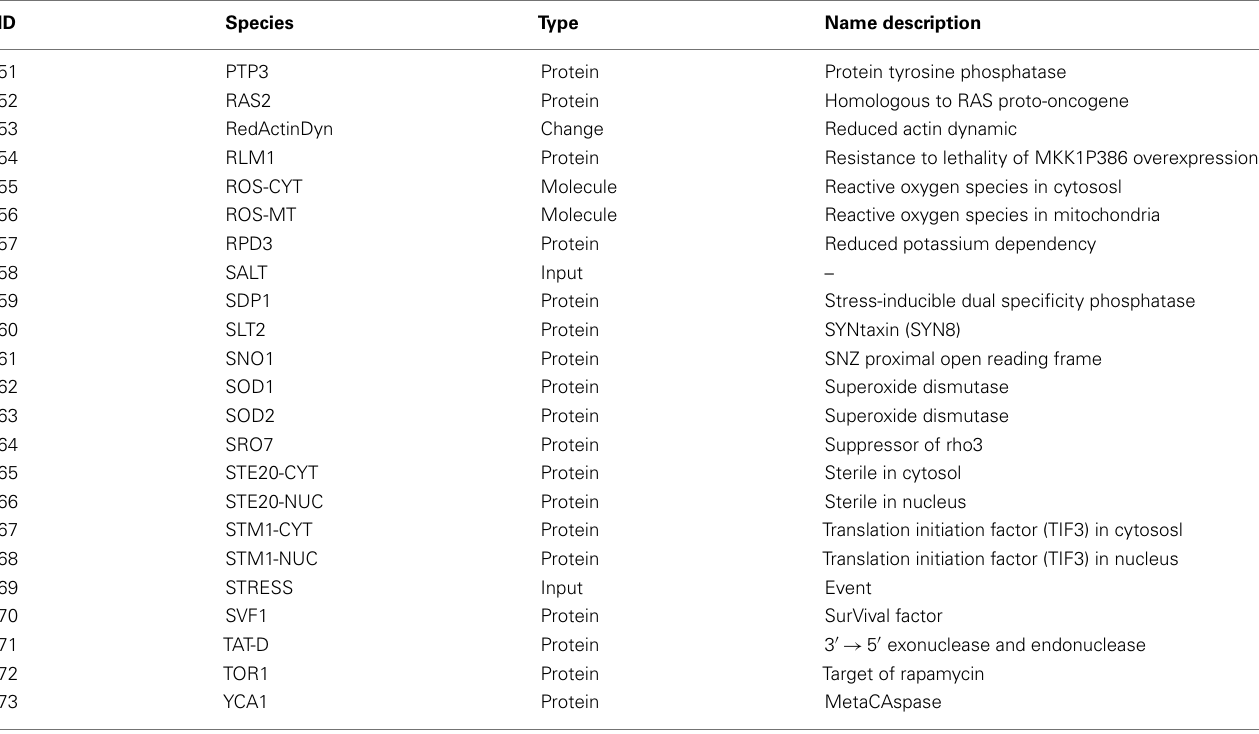
Table 2 | Summary of the interactions without successor (Sink/Output) and predecessor (Source/Input).